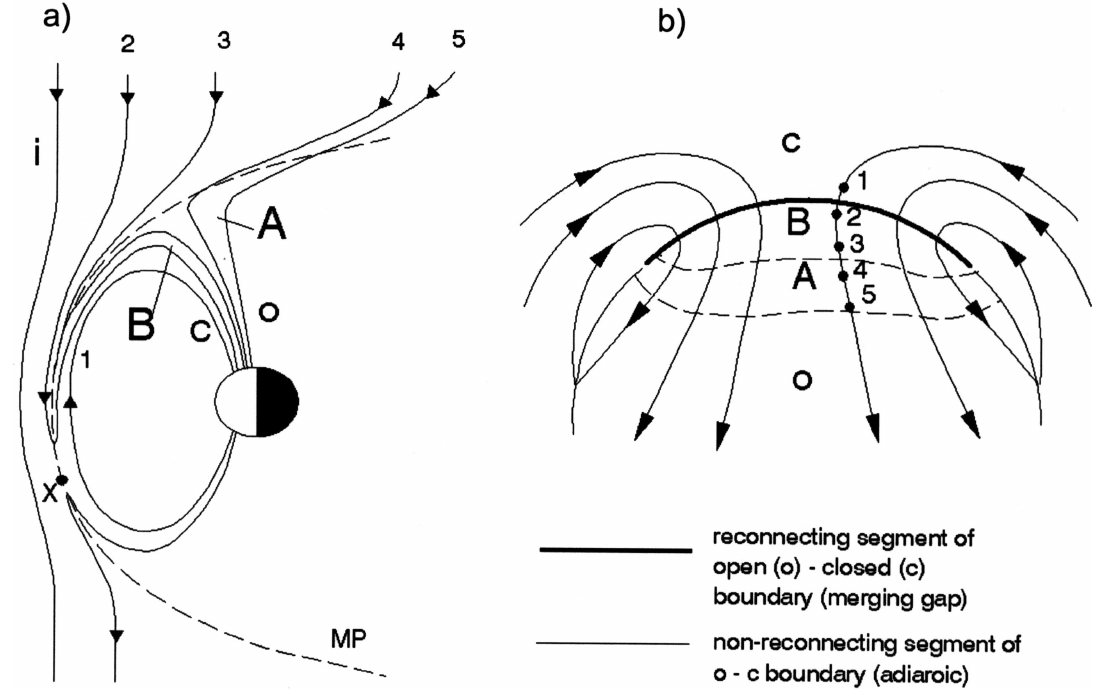
Fig. 12. (a) Schematic illustration of the dayside magnetosphere near the noon-midnight cross section of the magnetosphere, viewed from dusk and with the Sun to the left. X is a low-latitude reconnection site (between the magnetic cusps) converting closed field lines (c, such as field line 1) to open ones (o such as 2–5) that thread the magnetopause, the dashed line labelled MP, by reconnecting them with draped magnetosheath field lines (i). A and B are patches of newly-opened field lines produced by reconnection pulses at X. (b) The view looking down on the dayside polar cap in the northern hemisphere, with noon to the top and dawn to the right. The footprints of the field lines on the left are shown, following a convection flow streamline. The thick line is the ionospheric footprint of the reconnection line